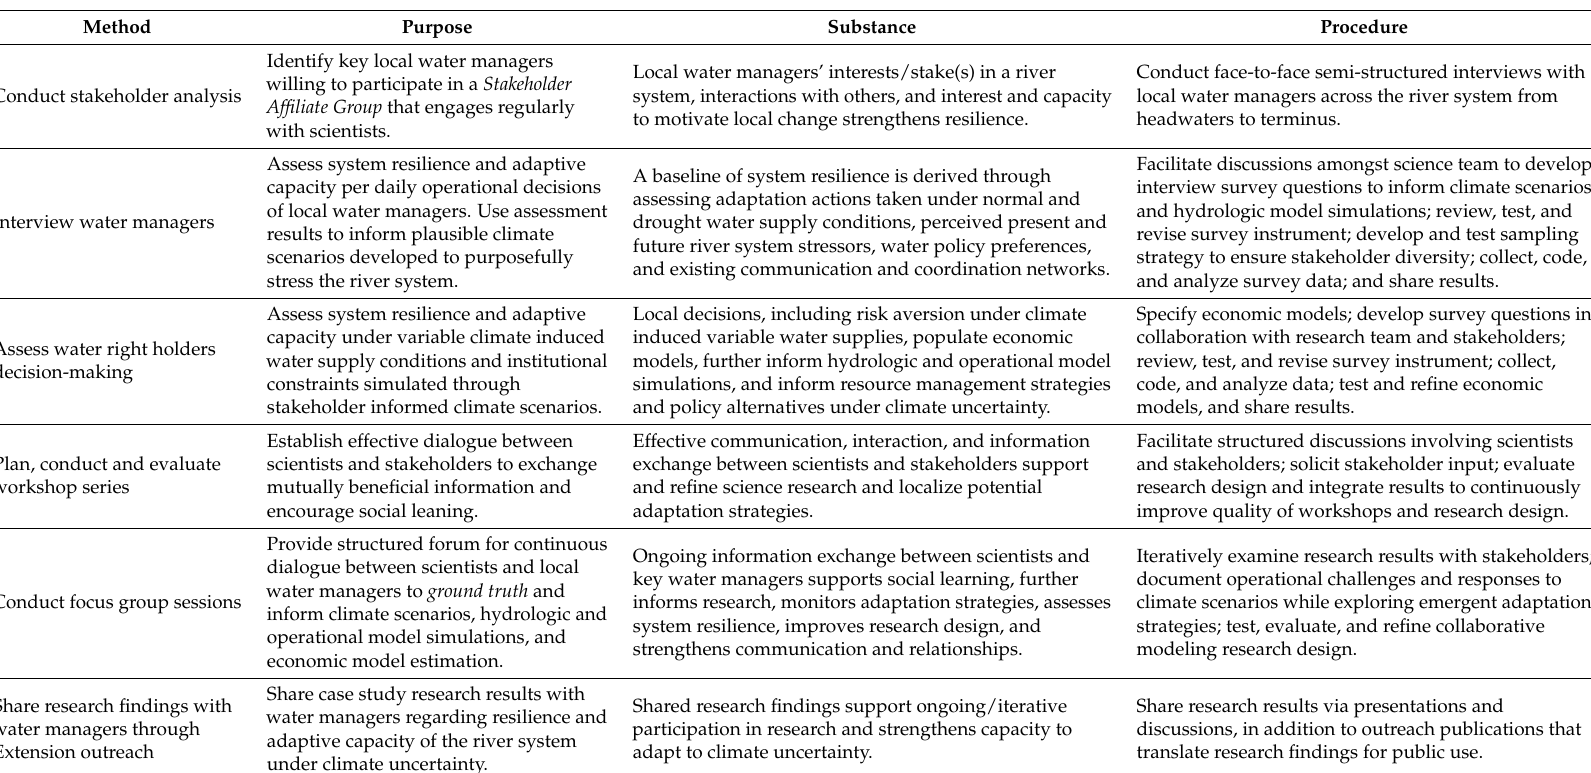
Table 1. Case study collaborative modeling research design. The collaborative modeling research design developed for this case study features a suite of standard primary data collection methods integrated with Extension outreach methods. The purpose of each method is to draw upon local knowledge and social learning to inform theoretically grounded hydrologic, operations, and economic